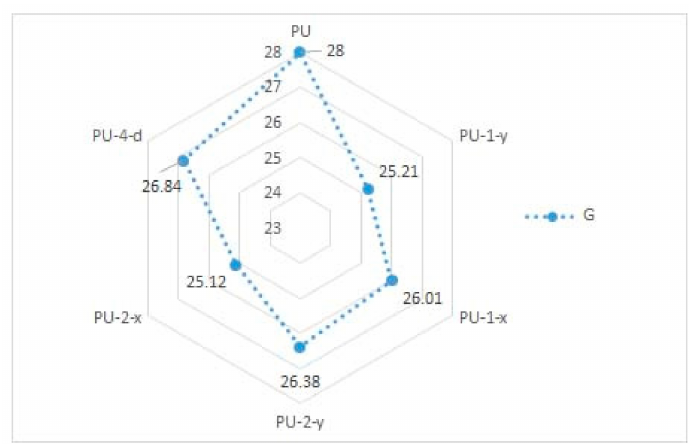
Figure 9. Bending stiffness (B) of polyurethane materials.